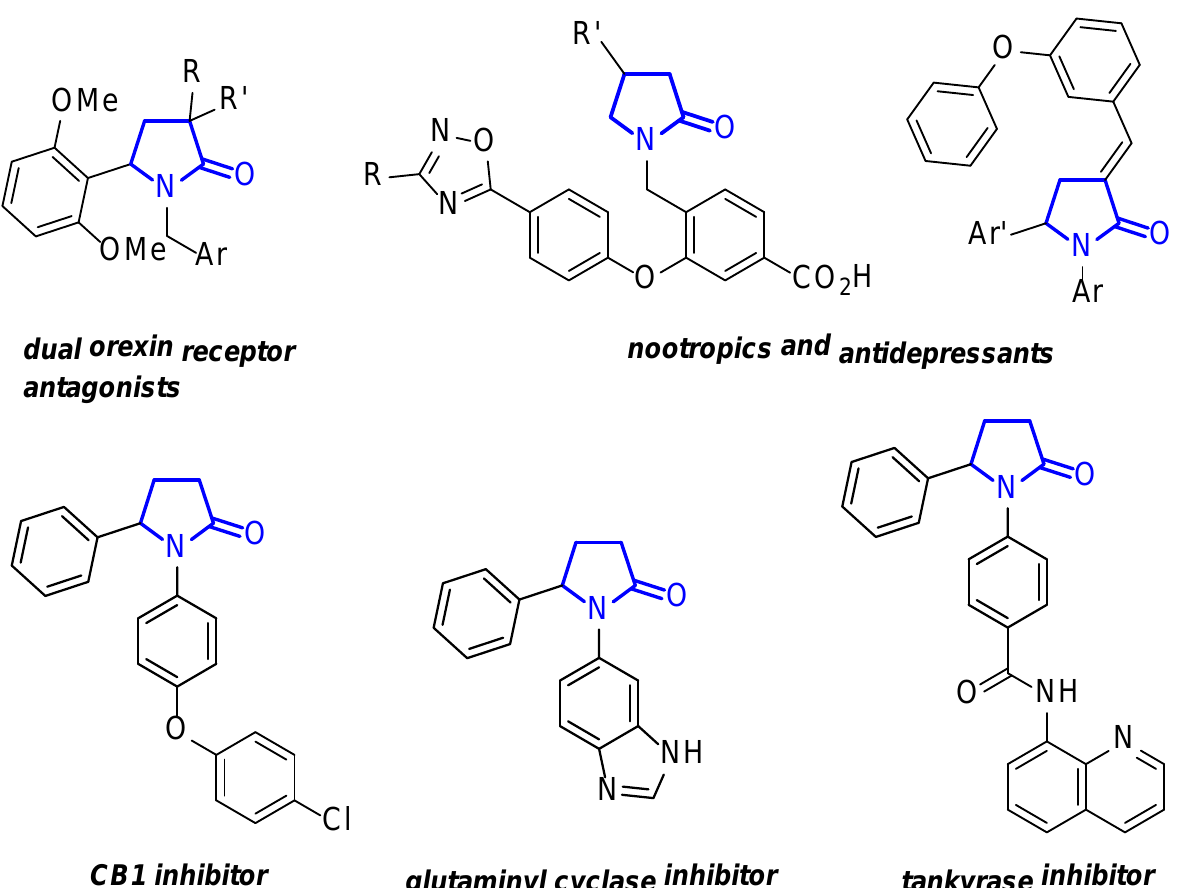
Figure 1. Bioactive molecules containing 1,5-diarylpyrrolidin-2-one or 5-aryl-1-benzylpyrrolidin-2- one frameworks.